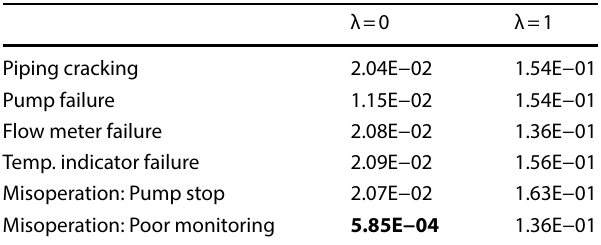
Table 4 Influence of each probability on the probability of the top event